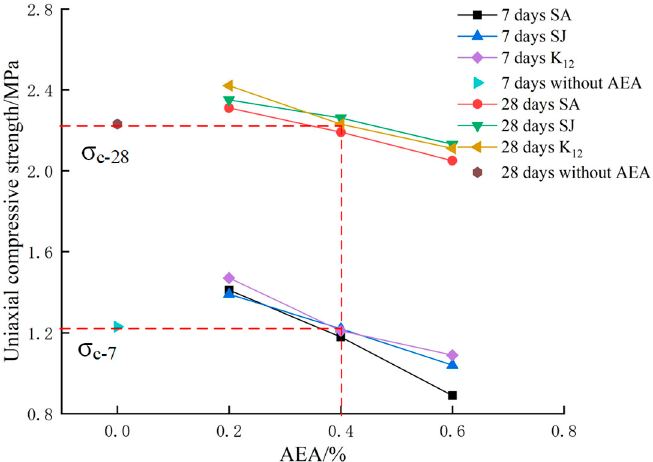
Figure 13. Uniaxial compressive strength of AEA for different curing ages.